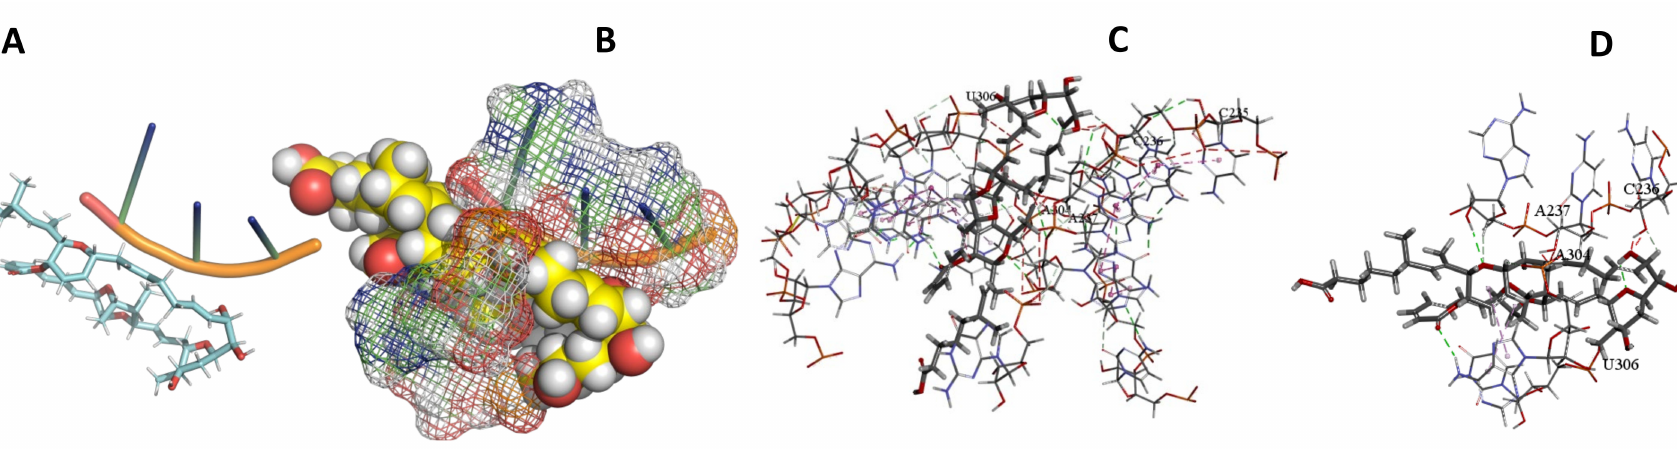
Figure 29. L. major + Sorangicin A. ( A ): Best binding pose and nucleotides involved. ( B ): Schematic binding pocket. ( C ): shows the Nucleotides component that re involved in binding. ( D ): Shows the main bonds involved between the compound and the nucleotide